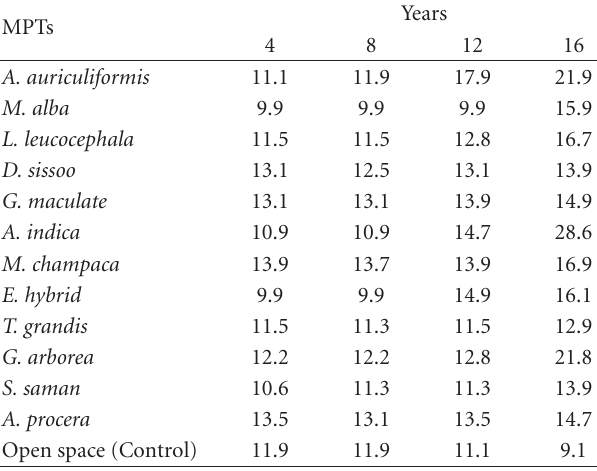
Figure 1: Energy requirement of di ff erent tillage practices. Source: [28]